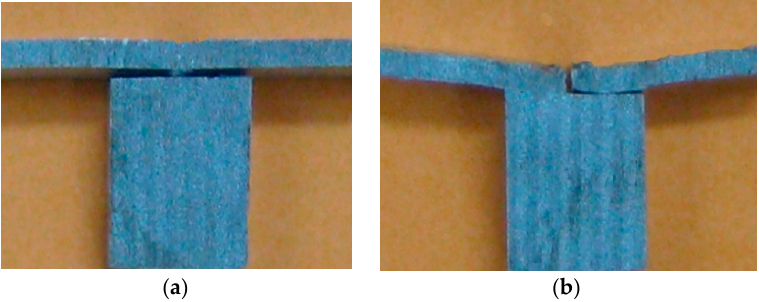
Figure 7. Macrographs of the failed tensile shear test specimens: ( a ) failed across the faying surface; ( b ) failed in the weld of the skin.